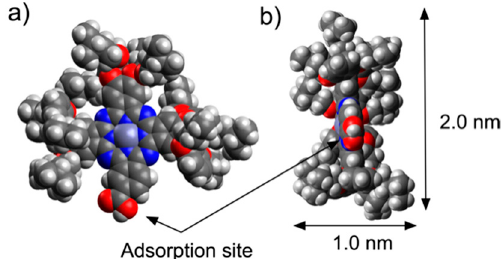
Figure 5. Corey–Pauling–Koltun (CPK) model of PcS27 (( a ) top view; ( b ) side view) calculated by Gaussian 16. Table 1. Photovoltaic performance of DSSCs sensitized with PcS27 and PcS28 . Dye